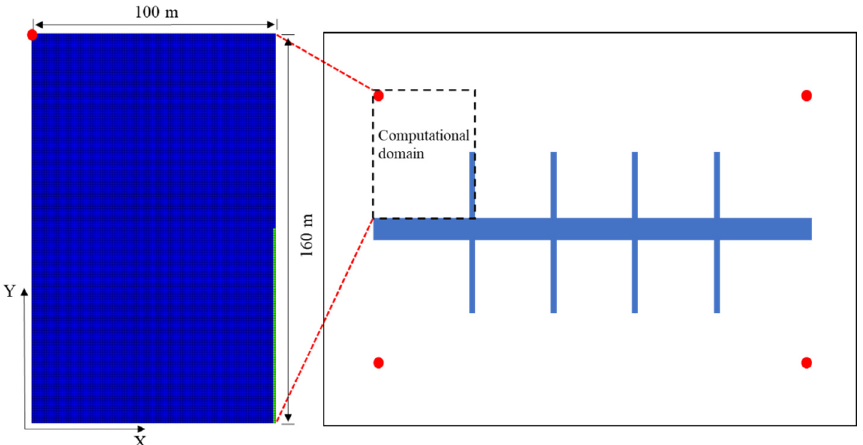
Figure 3. Simulation model of the fractured horizontal well. Table 3. Oil phase composition and properties.